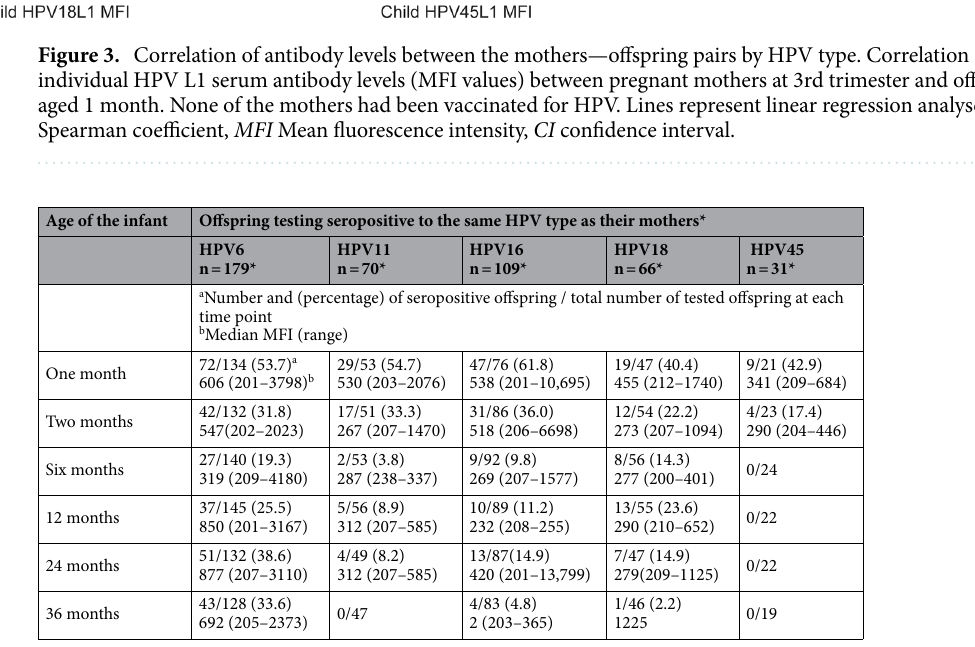
Table 1. Concordance of HPV type-specific (HPV6, 11, 16, 18, 45) seropositivity between the mothers and their offspring. The seropositivity cut-off in the mother–child pairs ≥ 200 MFI. *Numbers of mothers seropositive to HPV6 (n = 179), HPV11 (n = 70), HPV16 (n = 109), HPV18 (n = 66) and HPV45 (n = 31). a Numbers and (%) of the offspring testing seropositive to the same HPV type as their mothers/the total number of offspring tested at each time point. As an example of HPV6, 179 mothers (out of 327) tested seropositive to HPV6, but only 134 offspring of these mothers were serologically tested at 1-month; 132 at 2-month, 140 at 6-month, 145 at 12-month, 132 at 24-month and 128 at 36-month follow-up visit. The other HPV types follow the same pattern of presentation. b Median MFI values and